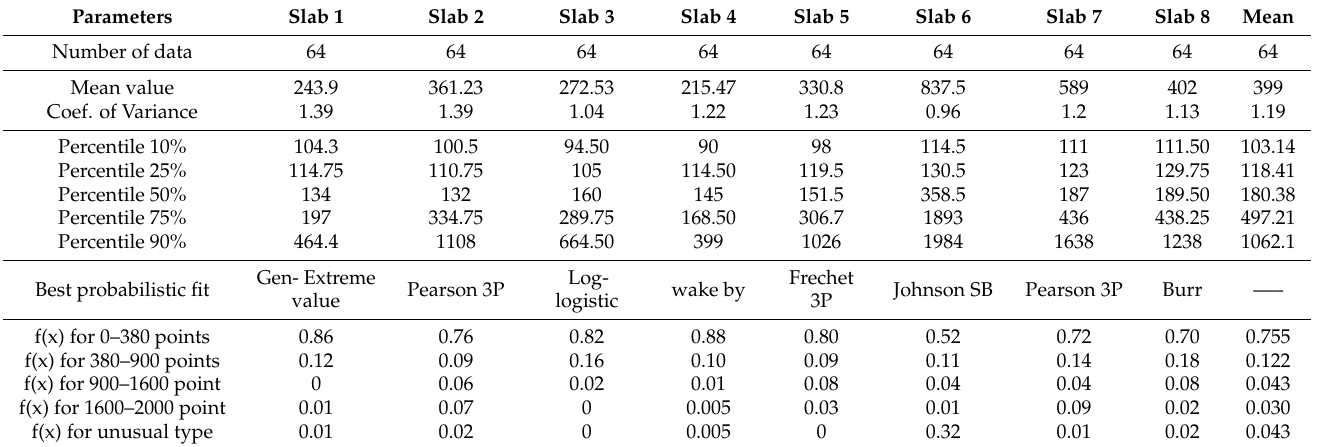
Table 1. Probability result for preprocessed IE signals based on signal length for defect area.